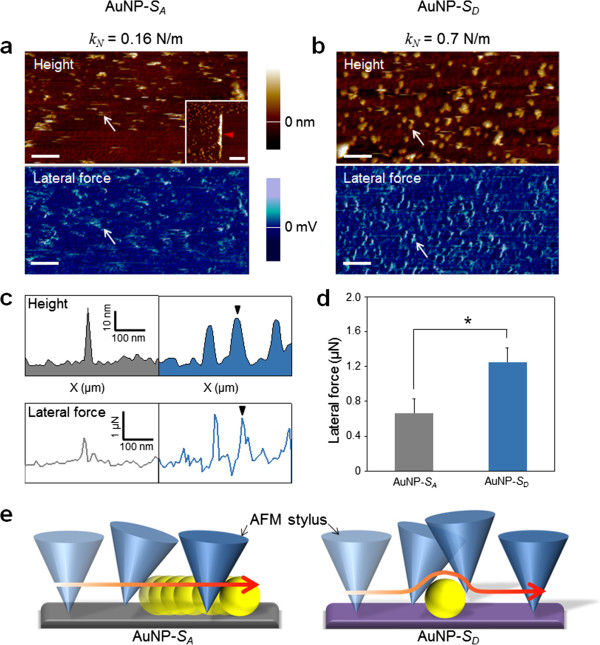
Lateral force microscopy analysis of binding affinity between AuNPs and chemically functionalized surfaces. (a, b) AFM topographic images and lateral force images of AuNPs immobilized on Si substrates, respectively, functionalized with (a) amino groups (AuNP-SA) and (b) catecholamine molecules (AuNP-SD) by different normal spring constants (kN) of microcantilevers. The inset shows left embankment (indicated by a red arrowhead) due to swept AuNPs formed by scanning the surface in AFM contact mode with kN = 0.7 N/m of microcantilever. All scale bars including that of the inset are 250 nm. (c) Line profiles corresponding to the white arrow in each image of (a) and (b) show the curves of scanner retracting distance versus the AuNP lateral displacement and the lateral force versus the lateral displacement, respectively. (d) Graph of the average lateral force of >100 AuNPs in (a) and (b) (the asterisk indicates p < 0.001) was extracted and calculated from the line profiles of lateral forces (c). (e) The model illustrates the physical interaction between the AFM tip and AuNPs attached on the chemically functionalized substrate (i.e., AuNP-SA and AuNP-SD).